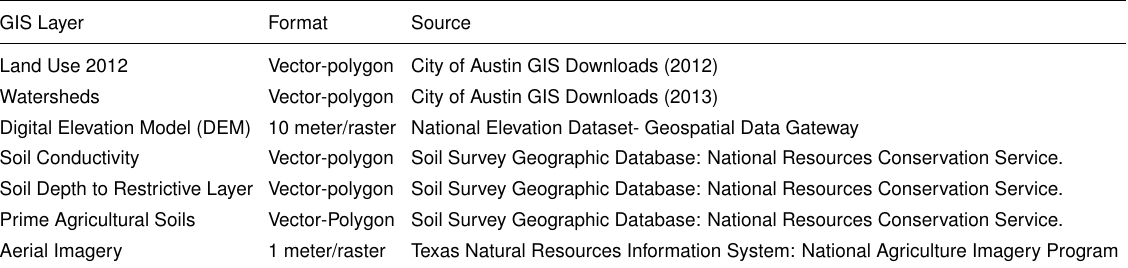
Table 1. Data layers used to inventory urban agriculture and create a topographic index at a watershed